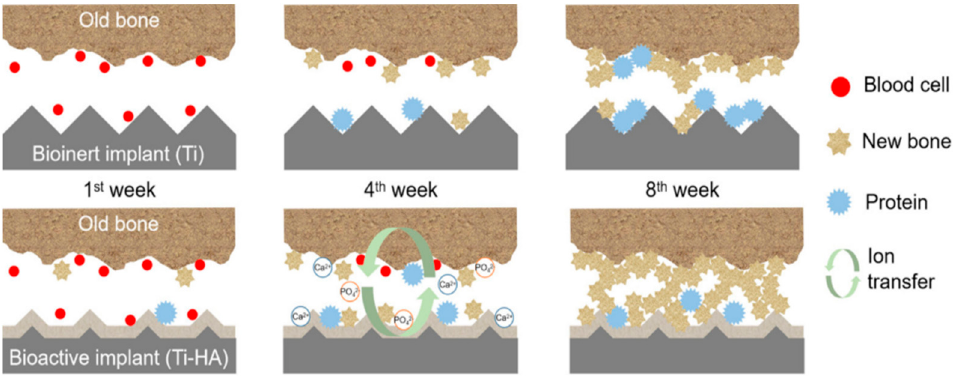
Figure 23. Implant osseointegration involving bioactive and inert prostheses shown schematically. Adapted with permission from [64] (MDPI) (2021). Distributed under Creative Commons Attribution-based license (CCBY 4.0.).